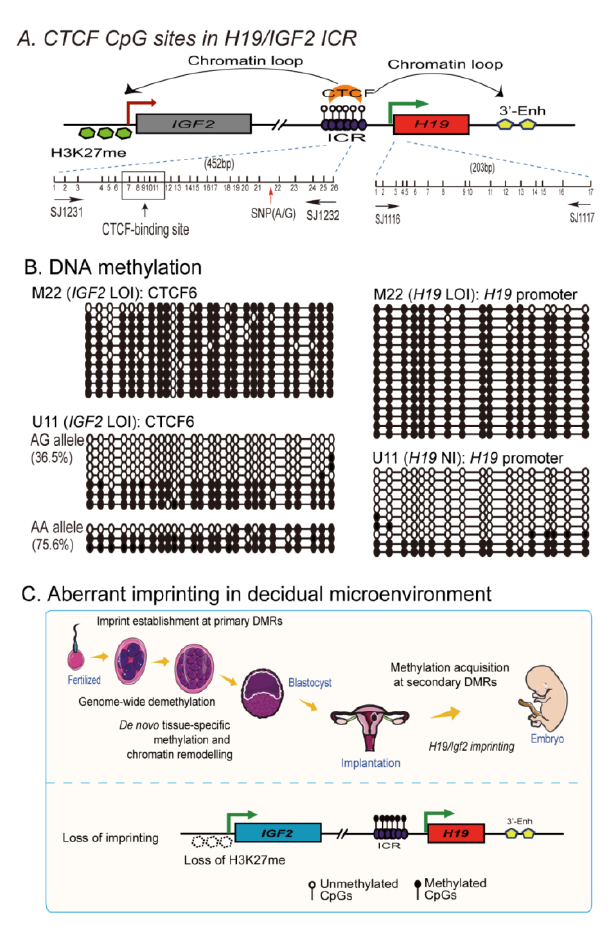
Figure 6. Abnormal DNA methylation at the CTCF6 site in the imprinting control region. ( A ) Schematic diagram of CpGs in the ICR. Locations of PCR primers are indicated by numbered arrows. Vertical lines: location of CpGs. Red arrows: single nucleotide polymorphisms allowing for discrimination of the two parental alleles in case U11. CTCF site 6 carrying CpG 7–11 is boxed. CTCF, a tethering protein, binds to the unmethylated ICR and serves as a molecular glue to secure intrachromosomal interactions. The CTCF-mediated looping brings the ICR and the IGF2 promoters into close contact, where the polycomb repressive complex 2 (PCR2) is recruited via SUZ12, inducing allelic H3K27 methylation and epigenetic imprinting. ( B ) Alteration of DNA methylation at the CTCF6 site and the H19 promoter in decidual tissues of cases with RSA (M22, U11). LOI: loss of imprinting. NI: not informative. Numbers in parenthesis: percentage of methylated CpGs. Note